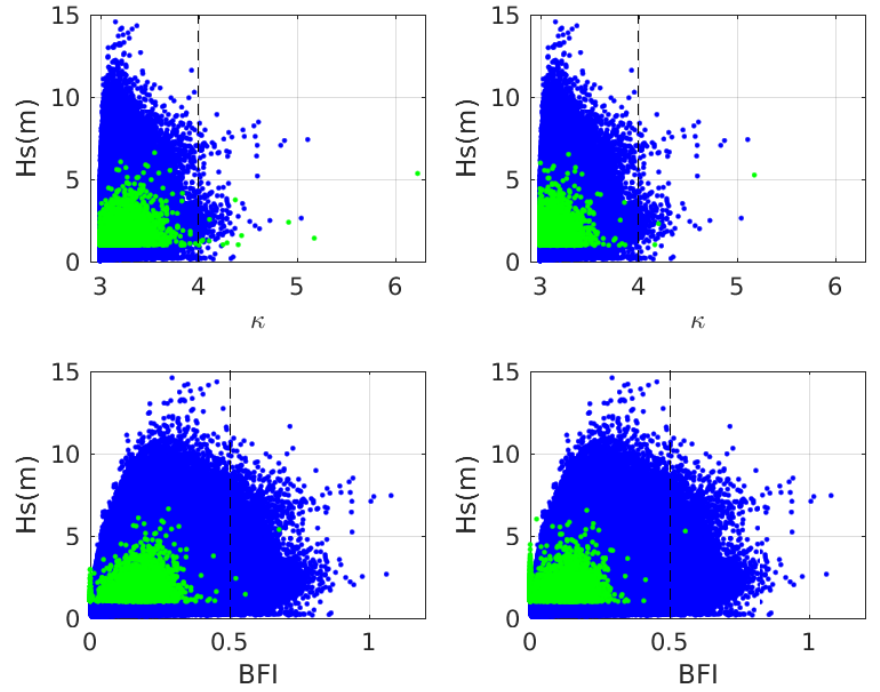
Figure 7. Comparison of H s , kurtosis ( κ ), and BFI statistics for rogue (green) and non-rogue (blue) datasets. Left panels have rogue statistics computed with rogue events included in each sample. Right panels have rogue statistics computed with rogue events excluded from each sample. Heavier dashed vertical line added in each panel to better illustrate shift toward lower values when individual rogues are excluded.